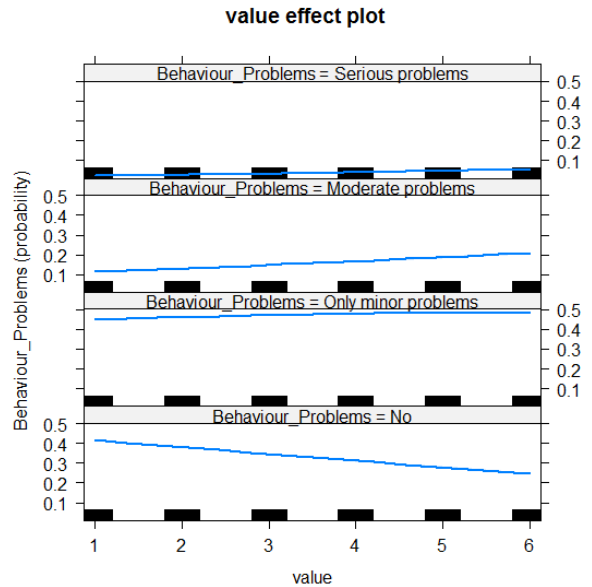
Figure 1. Value effect plot for the ridden horse questionnaire items showing the probability of behaviours reported by the four self-reported categories (no problems, only minor problems, moderate problems and serious problems). The more undesirable or dangerous the behaviours reported were, the higher the value scored for the horse. Value 1 represents not applicable/not observed, value 2 represents never and value 6 represents always.